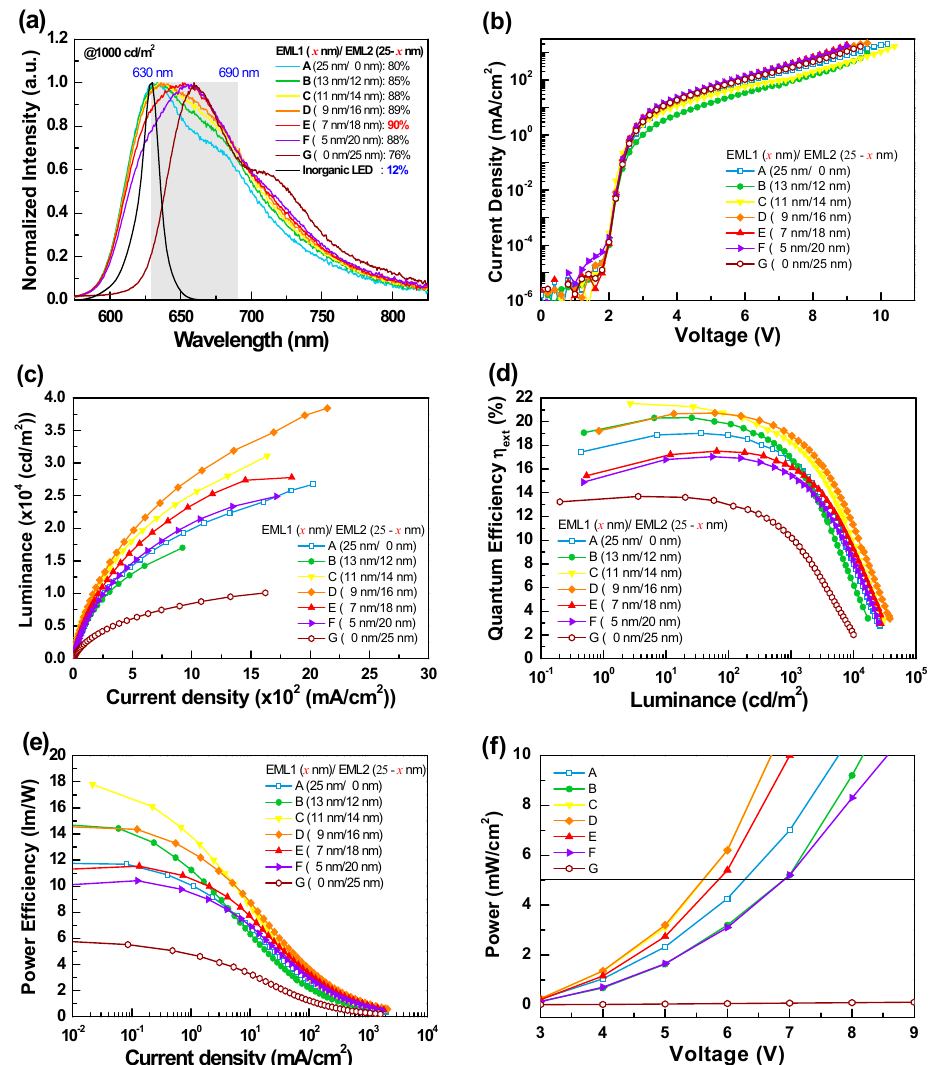
Figure 4. ( a ) Normalized EL spectra at a luminance of 10 3 cd/m 2 , ( b ) current density- voltage ( J - V ) characteristics, ( c ) luminance-current density ( L - J ) characteristics, ( d ) external quantum efficiency versus luminance, ( e ) power efficiency versus current density, ( f ) power density versus voltage for devices A, B, C, D, E, F, and G.